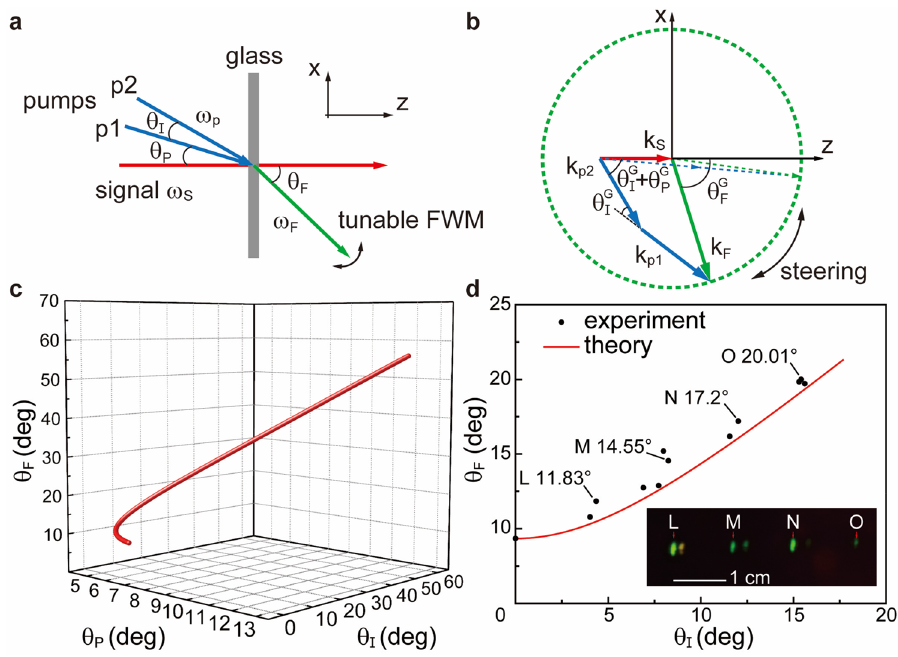
Figure 5. Demonstration of nonlinear FWM steering to a large angle. (a ) In contrast to the degenerate one, the non-degenerate pumps now are separated with θ I denoted as the intersection angle between p1 and p2, θ p as p1 to the signal(normal incidence). By properly choosing these angle relations and considering the phase matching, the FWM beam can be steered to a wider angle θ F as shown in ( b ). In this manner, the FWM beam can be steered from 9.34° to nearly 90° (6.14°—41.23° for θ G F ) in the x ~ z plane. The dashed green circle implies all possible endpoints for tuned FWM beam vectors within the glass slab. ( c ) All the possible steering angles in a 3D angle box with two input variants, i.e., θ p & θ I . ( d ) Experimental measurements for the non-degenerate FWM steering angles based on ( b ). We define the variant x -axis as the intersection angle for the two pumps( θ I ). Black dots are experimental results and the red curve presents the theoretical calculation from Eq. (9). The insert slice denotes the images taken 210 mm away from the glass slab demonstrating a beam steering at angles 20.01º( O ), 17.20°( N ), 14.55°( M ), 11.83° (L